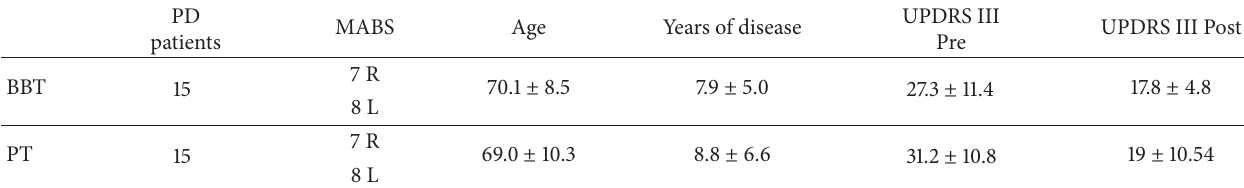
Table 1: Clinical and demographic characteristics of Parkinson’s Disease